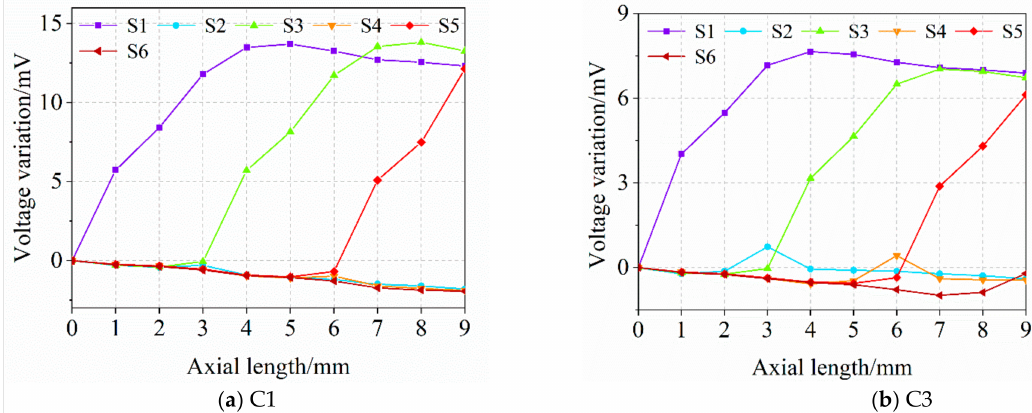
Figure 14. Voltage variation versus axial length.